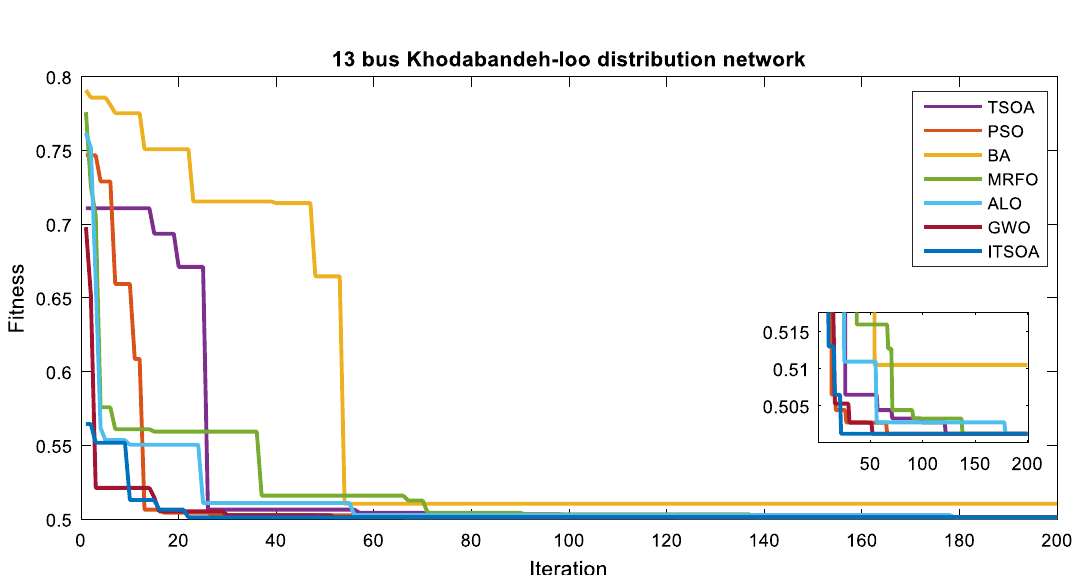
Figure 4. Convergence process of the algorithms in multiobjective reconfiguration solution, unbalanced 13-bus network.